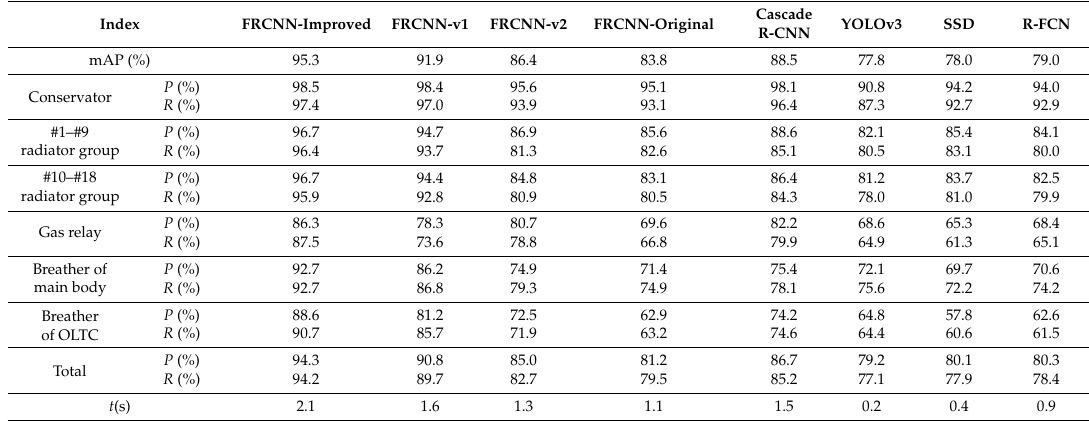
Table 5. Statistical results of different models.